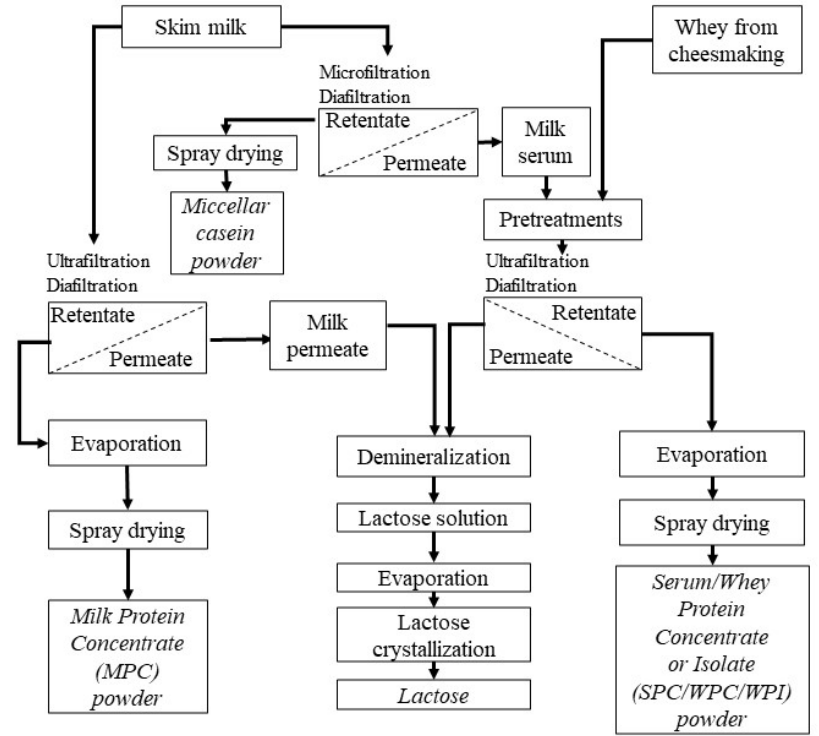
Figure 1. Flow diagram for concentration of proteins and lactose production in dairy industry. The final products are marked in italics.